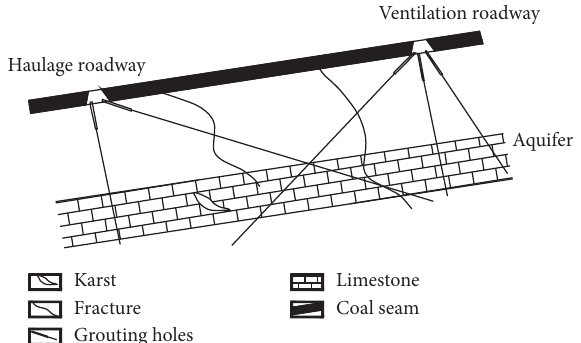
Figure 1: Schematic of process of grouting of coal seam